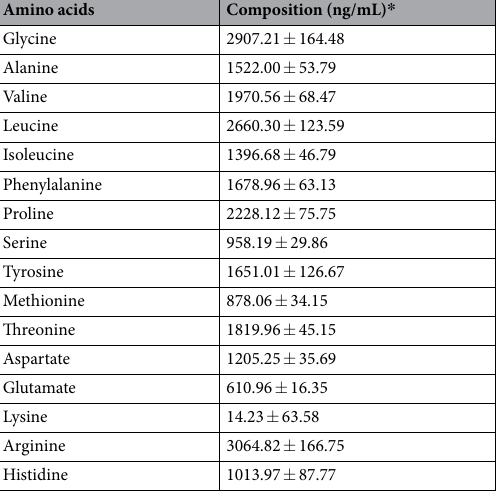
Table 6. Free amino acid composition in DSM hydrolysates. * Values were given by mean ± standard (n = 3).